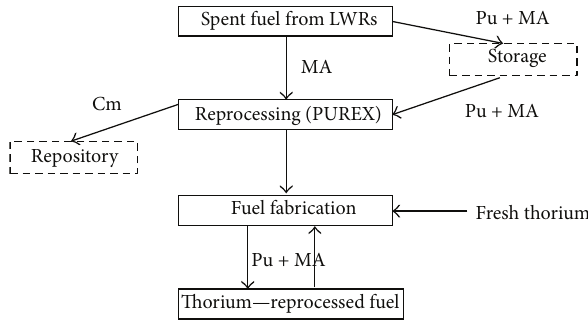
Table 4: Composition of nuclear waste after 50GWd/t of heavy metal burnup.